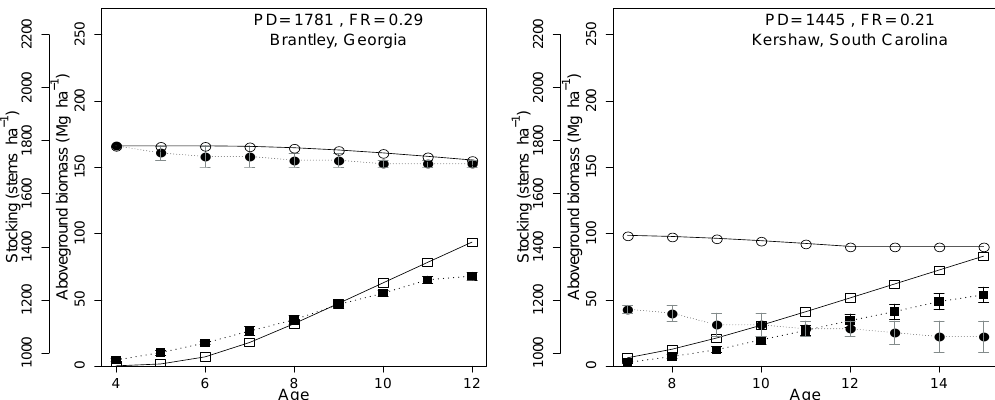
Figure 5. The relationship between observed (dotted line, filled rectangles and circles) and 3-PG predicted (solid line, unfilled rectangles and circles) values for aboveground biomass (rectangle) and stand density (circle) in some of the study sites. The species